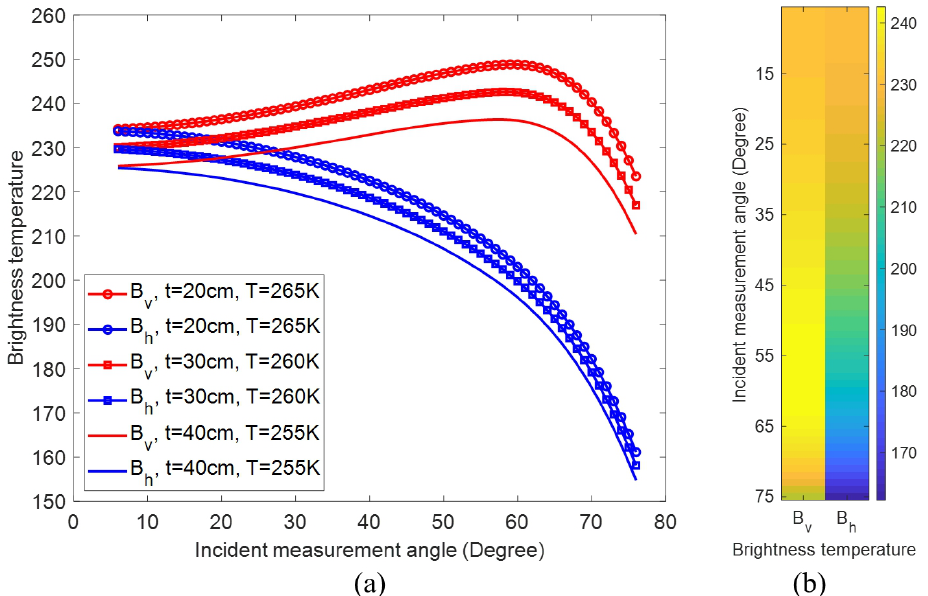
Figure 3. ( a ) the brightness temperature B v in vertical polarization and B h in horizontal polarization with t = 30 cm and T = 260 K; ( b ) the ’field-data’ [ B v , B h ] as the input of ConvNet.